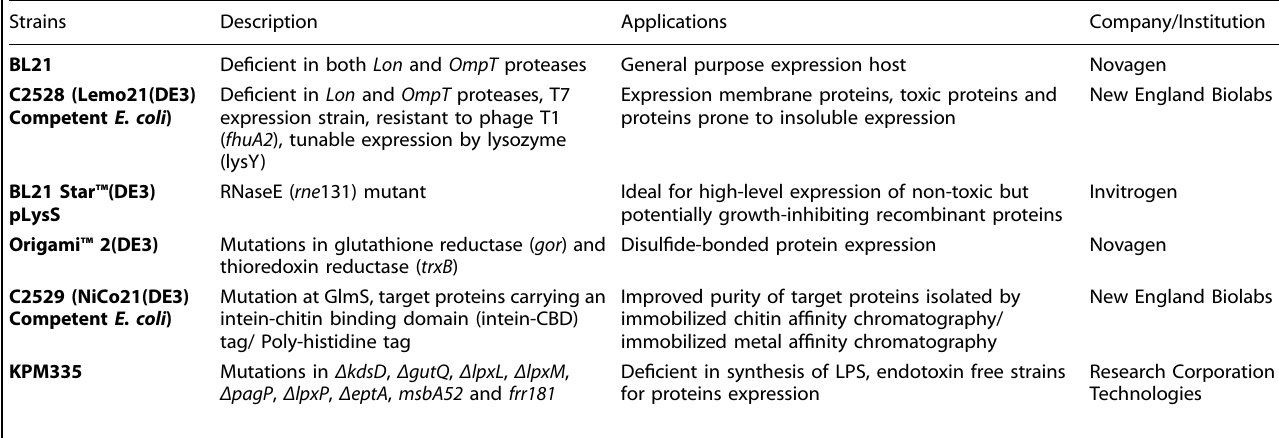
Table 3. Representative recombinant E. coli strains for protein expression Strains